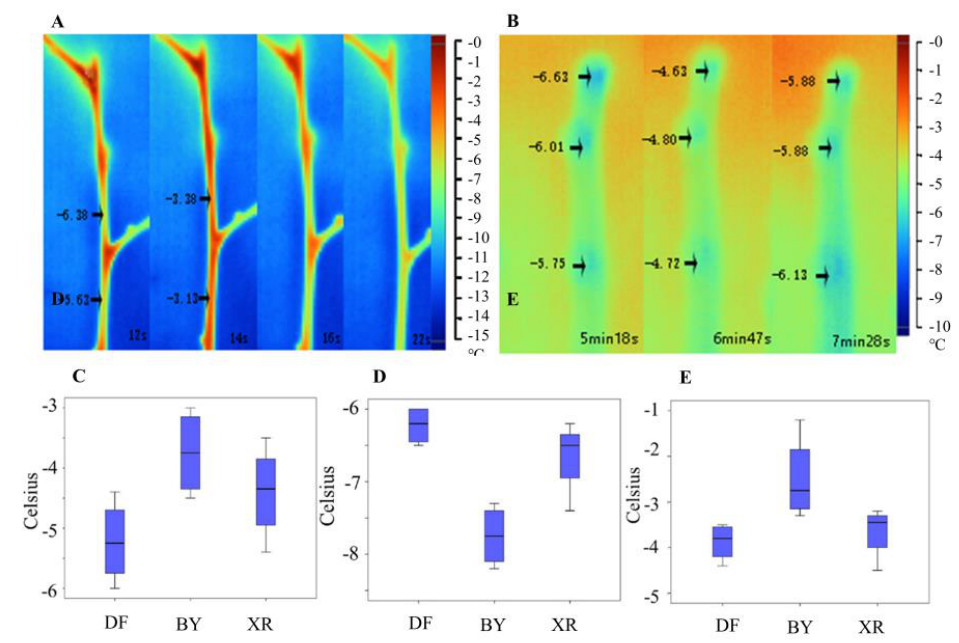
Figure 1. Branch and bud freezing temperature statistics and diagrams of the exothermic processes of icing. Diagrams of the icing processes of stems ( A ); and buds ( B ) in XR captured with infrared cameras. Box diagrams based on icing temperature statistics ( C – E ): ( C ), one-year-old branches of mature trees; ( D ), flower buds of mature trees; and ( E ), branches of one-year-old grafted seedlings.